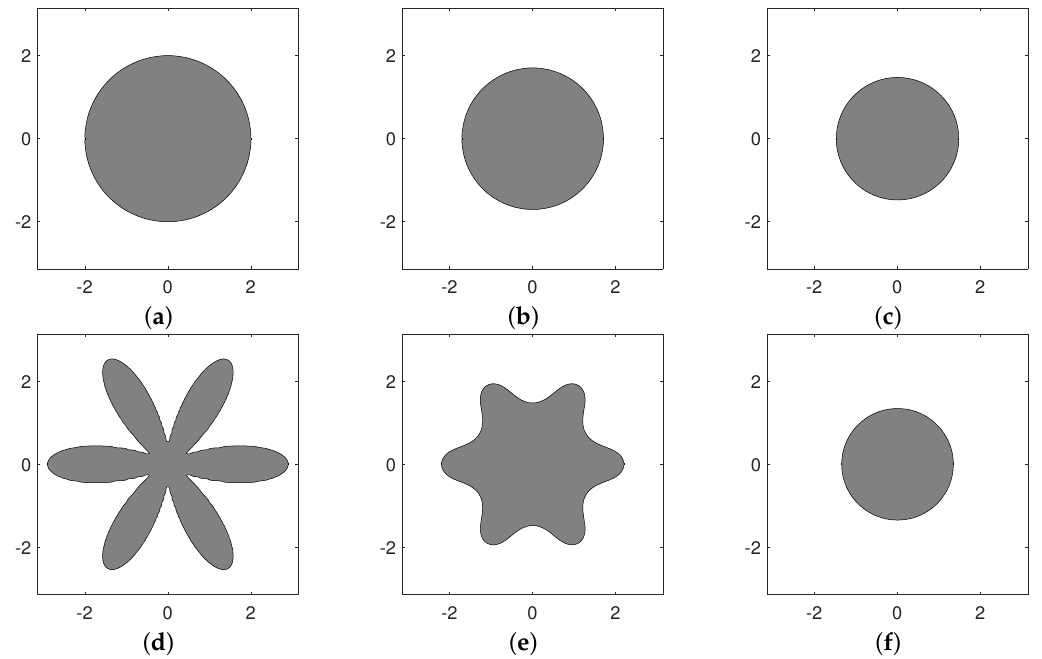
Figure 6. ( a ) Initial condition (34) . ( b , c ) Numerical solutions of the Allen–Cahn (AC) equation after 6000 and 10,000 iterations with ∆ t = 0.0001, respectively. ( d ) Initial condition (35) . ( e , f ) Numerical solutions of the AC equation after 2000 and 10,000 iterations with ∆ t = 0.0001,